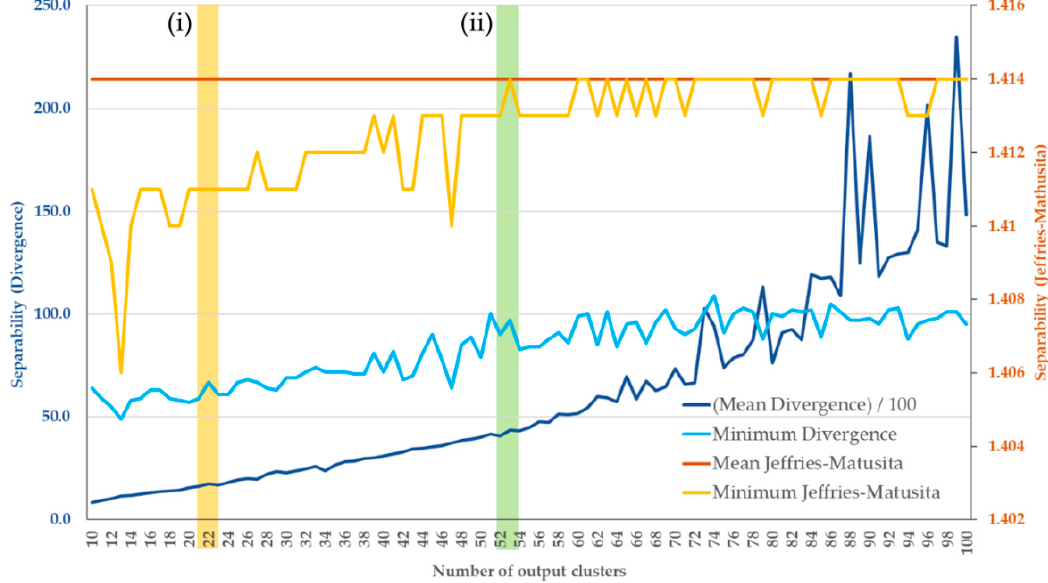
Figure 4. A graphical illustration of the separability analysis which determined the optimal number of data clusters. The estimates of all four separability measures between clusters are plotted against the number of clusters produced by the ISODATA clustering. Note that (mean divergence)/100 is shown for visualisation purposes. Highlight (i) in orange shows the 22 clusters which would have been selected using de Bie et al.’s LaHMa approach [28], solely looking for coincident peaks in divergence measures, without consideration of the Jeffries-Matusita separability measure. Highlight (ii) in green shows the location of a peak which satisfies both the divergence peak criteria, and the Jeffries-Matusita criteria needed for the more objective OHMA approach.